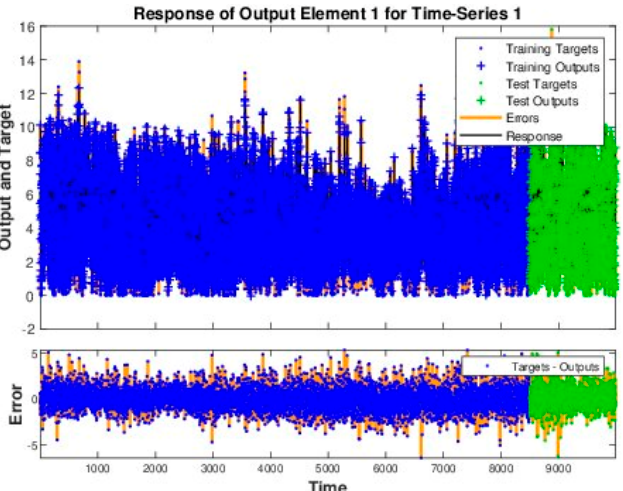
Figure 22. Error histogram plot of neural network (wind velocity forecasting case).